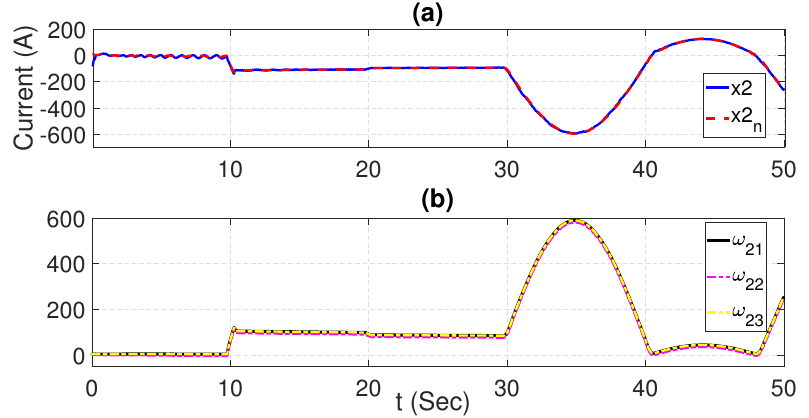
Figure 2. Current identification ( a ) and NN’s weights ( b